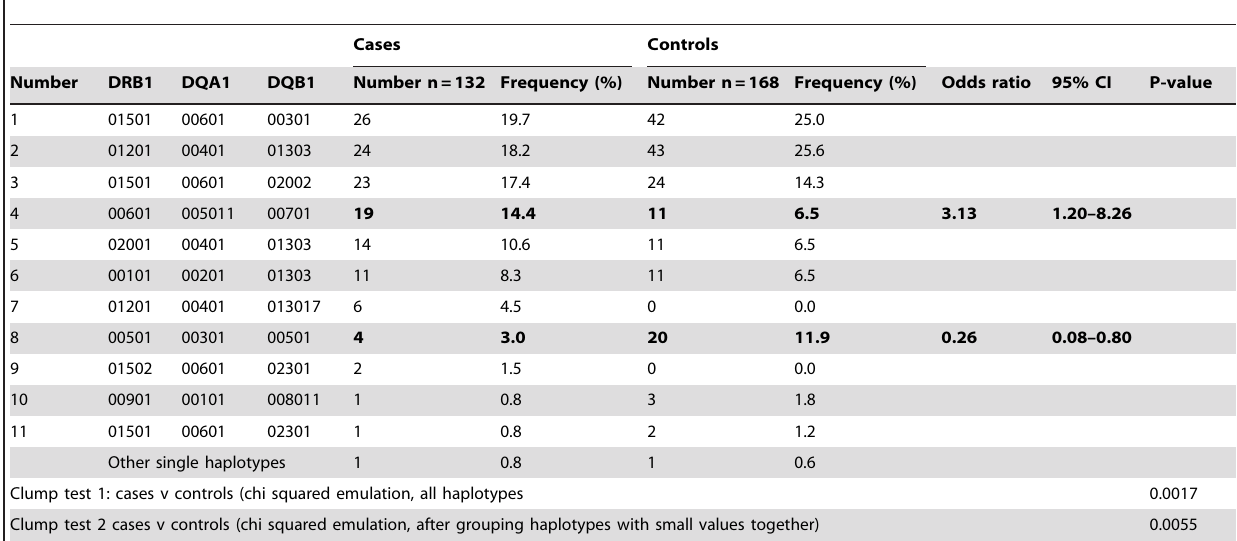
Table 2. Frequencies of three locus DLA class II haplotypes in 66 ESSs with CH and 84 healthy controls.